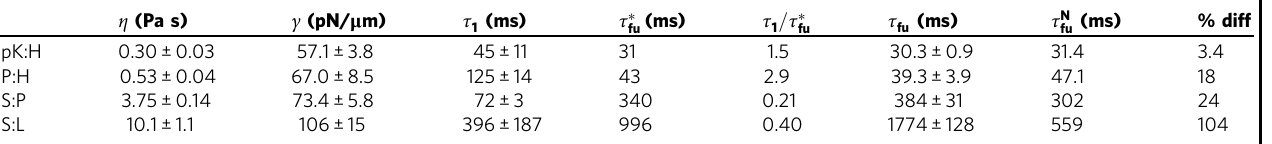
Table 1 Material properties and fusion times of four types of